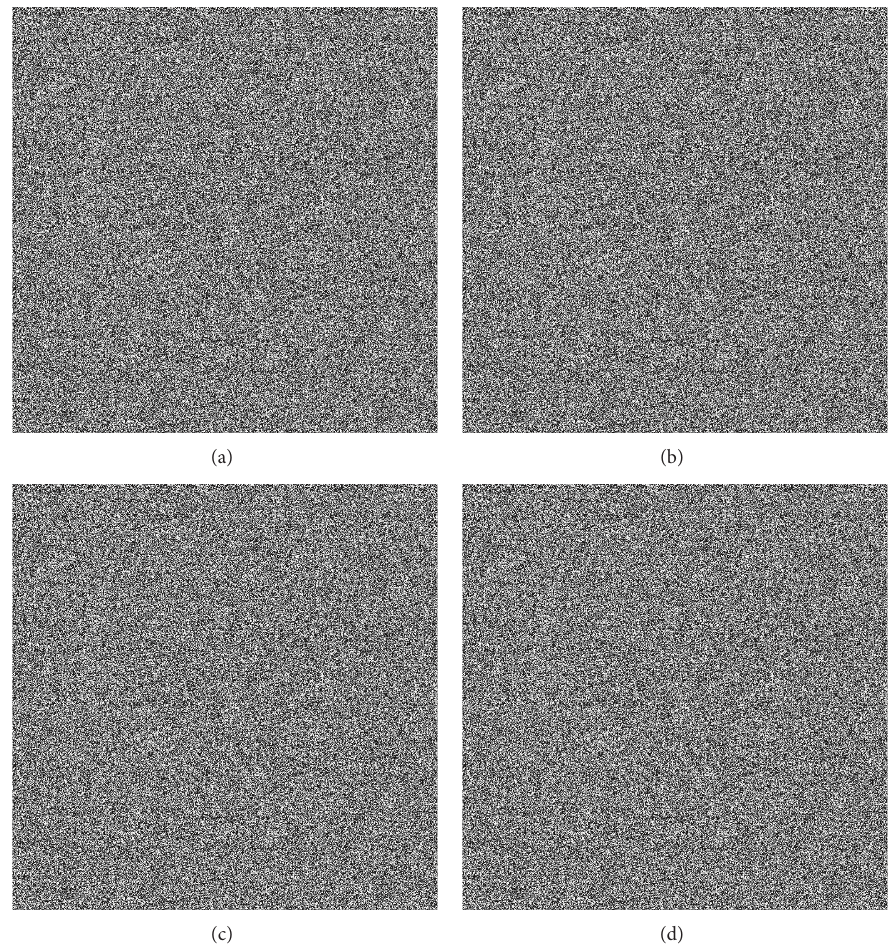
Figure 4: Frames (a)–(d) show the decrypted images from the encrypted image of Figure 3(b) using slightly different keys compared to the key used for encryption.